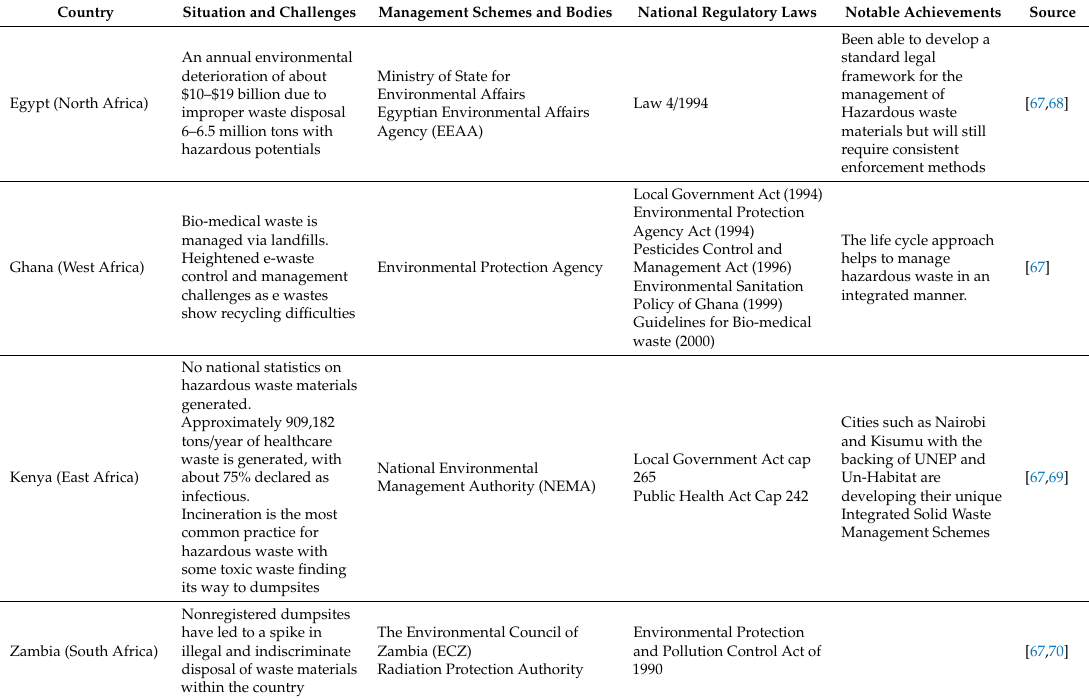
Table 2. Summary of Hazardous Waste Management Practices from Select Countries in